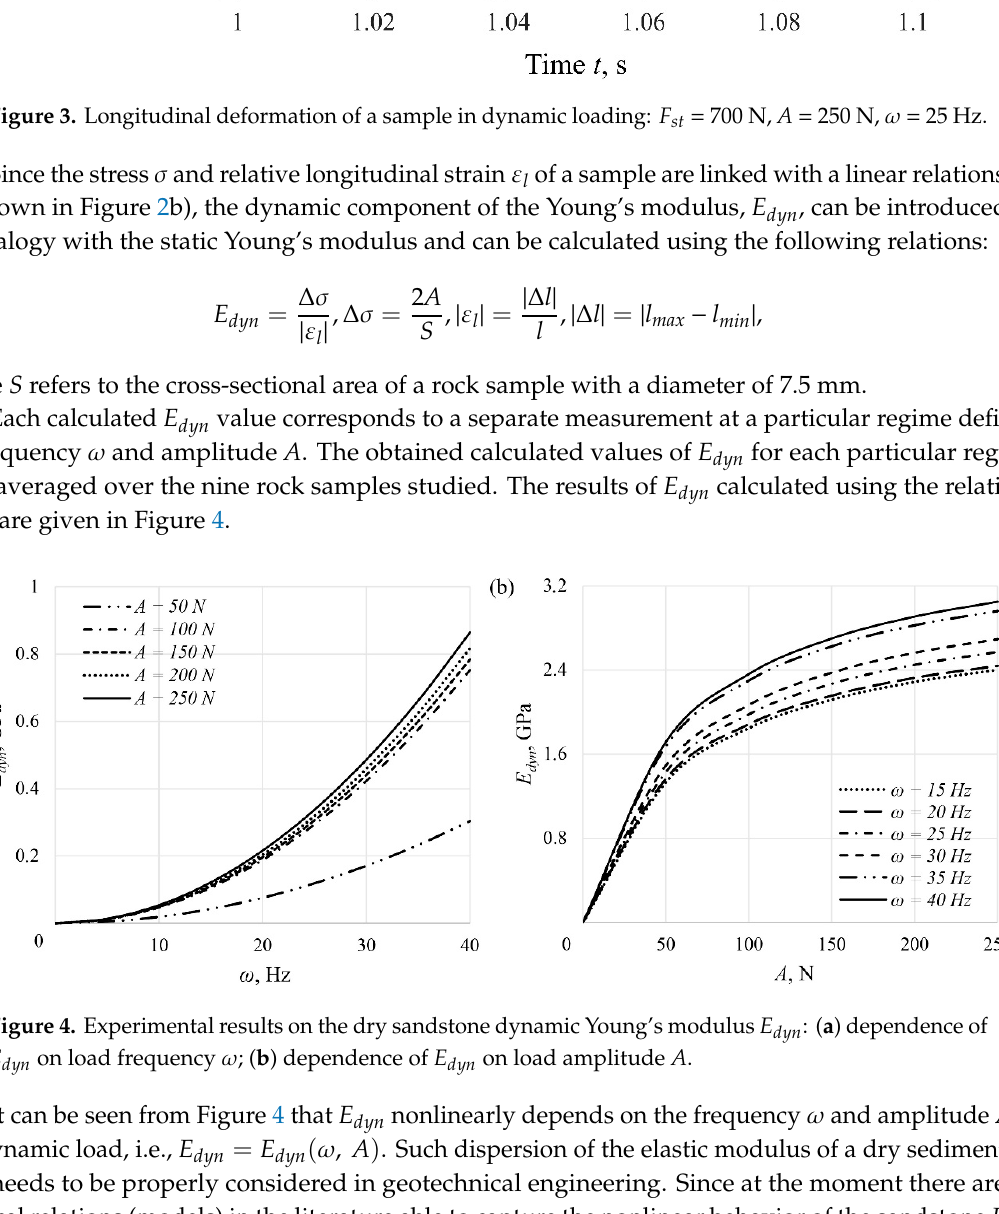
dyn : ( a ) dependence of